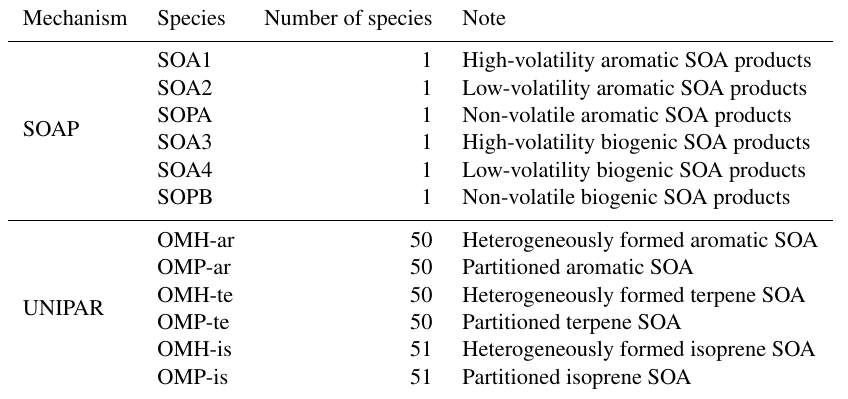
Table 2. List of SOA products in the SOAP and UNIPAR